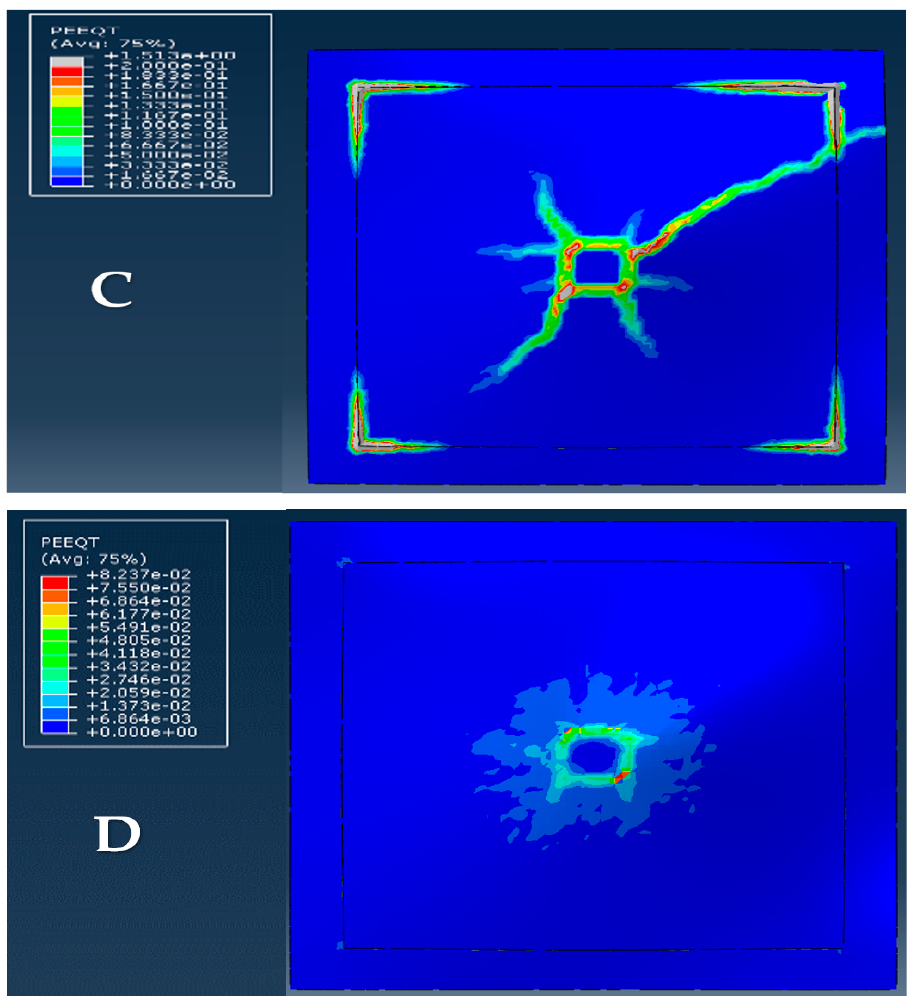
Figure 14. Crack pattern distribution for: ( A ) NSC slabs, ( B ) SIFCON slab with micro steel fibres, ( C ) SIFCON slab with hook end fibres, and ( D ) SIFCON slab with hybrid steel fibres.